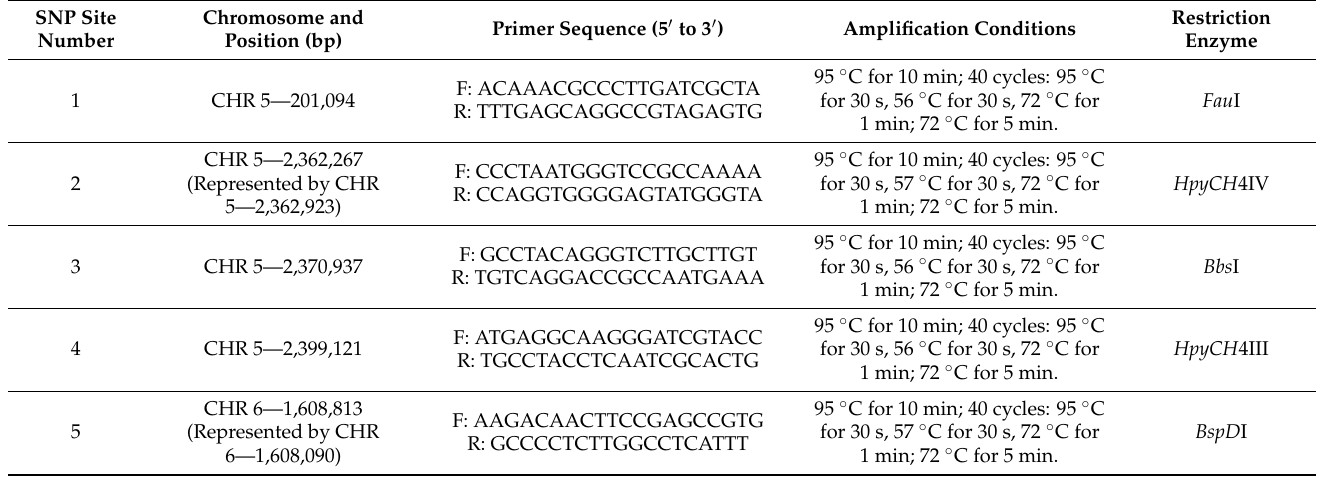
Table 1. The primers, amplification conditions, and restriction enzymes used for distinguishing the five SNP sites between parental strains CM11 and AFB62-1 as well as their